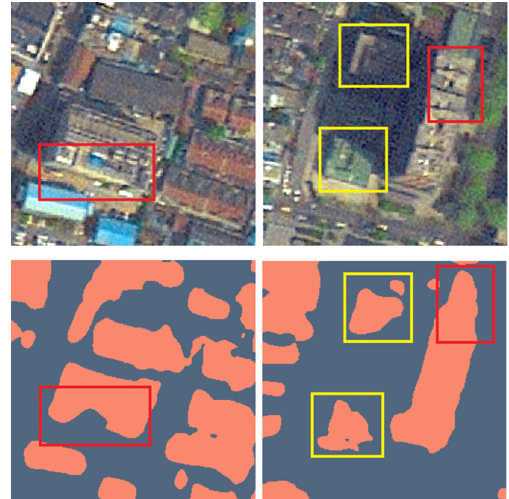
Figure 8 Problems in Building Extraction Results. The red